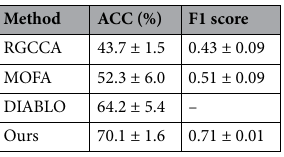
Table 6. Comparison of results on TARGET